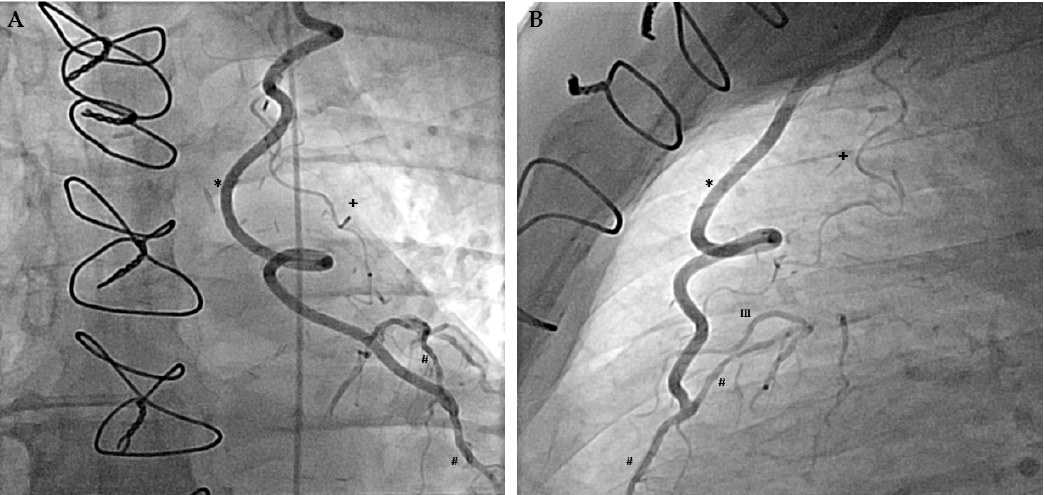
Figure 2. Angiographic demonstration of extracardiac coronary supply after coronary artery bypass surgery. ( A ) Posterior-anterior projection of the left internal mammary artery bypass (marked by a *) on the left anterior descending coronary artery (LAD, marked by a #). Upstream of the bypass anastomosis, retrograde filling of the LAD is incomplete revealing coronary occlusion, which triggered the arteriogenesis of the pericardiacophrenic branch (marked by a +) ( B ) Lateral projection using the same markers revealing the connection of the pericardiacophrenic branch with the third diagonal branch (marked by III).